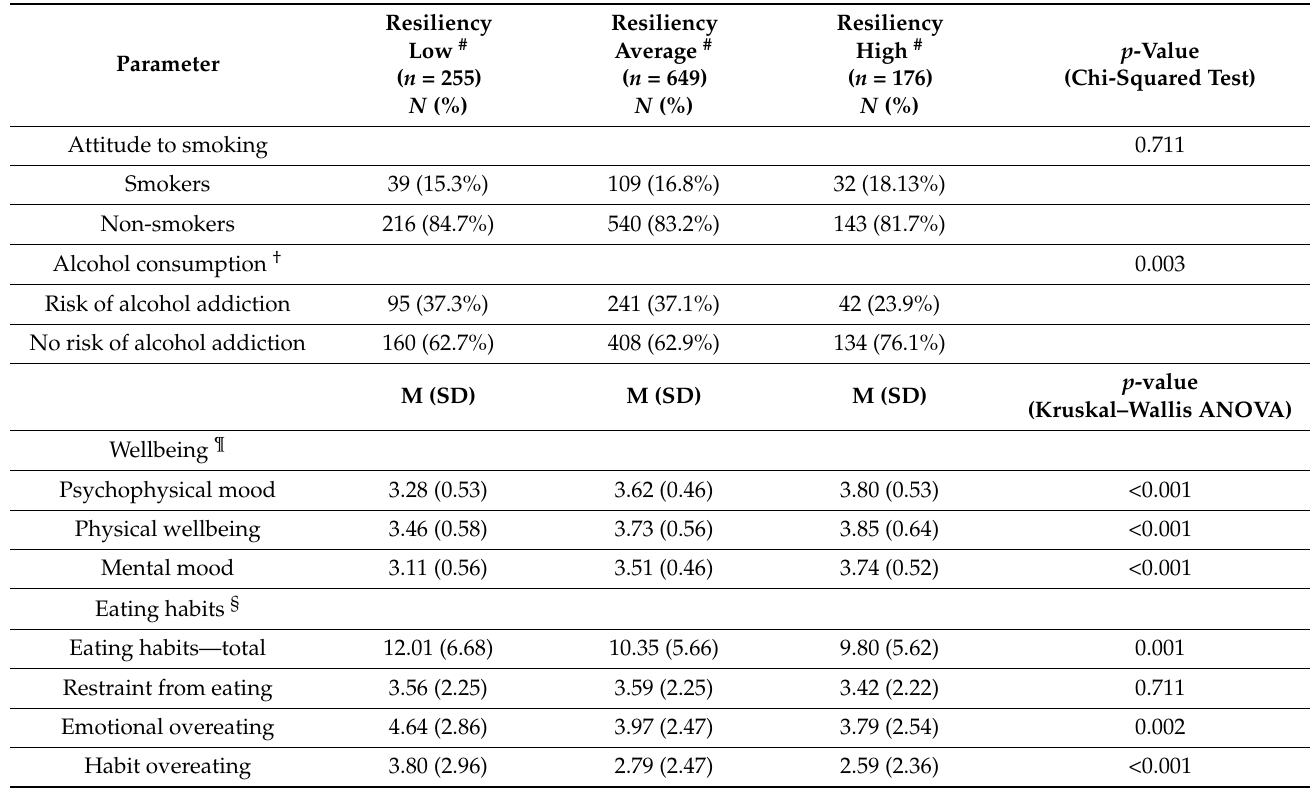
Table 5. Comparison of resilience among various forms of risky behaviour and